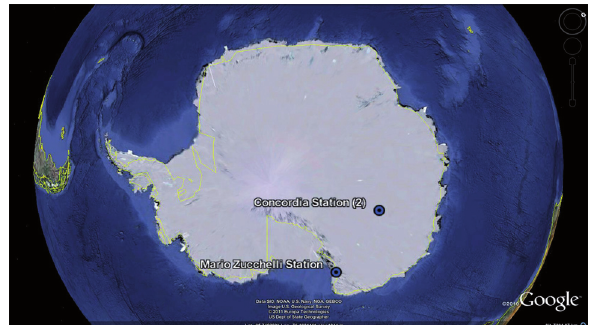
Figure 1. Location of the ISACCO stations in Antarctica, with two receivers at Concordia station and one receiver at Mario Zucchelli station.